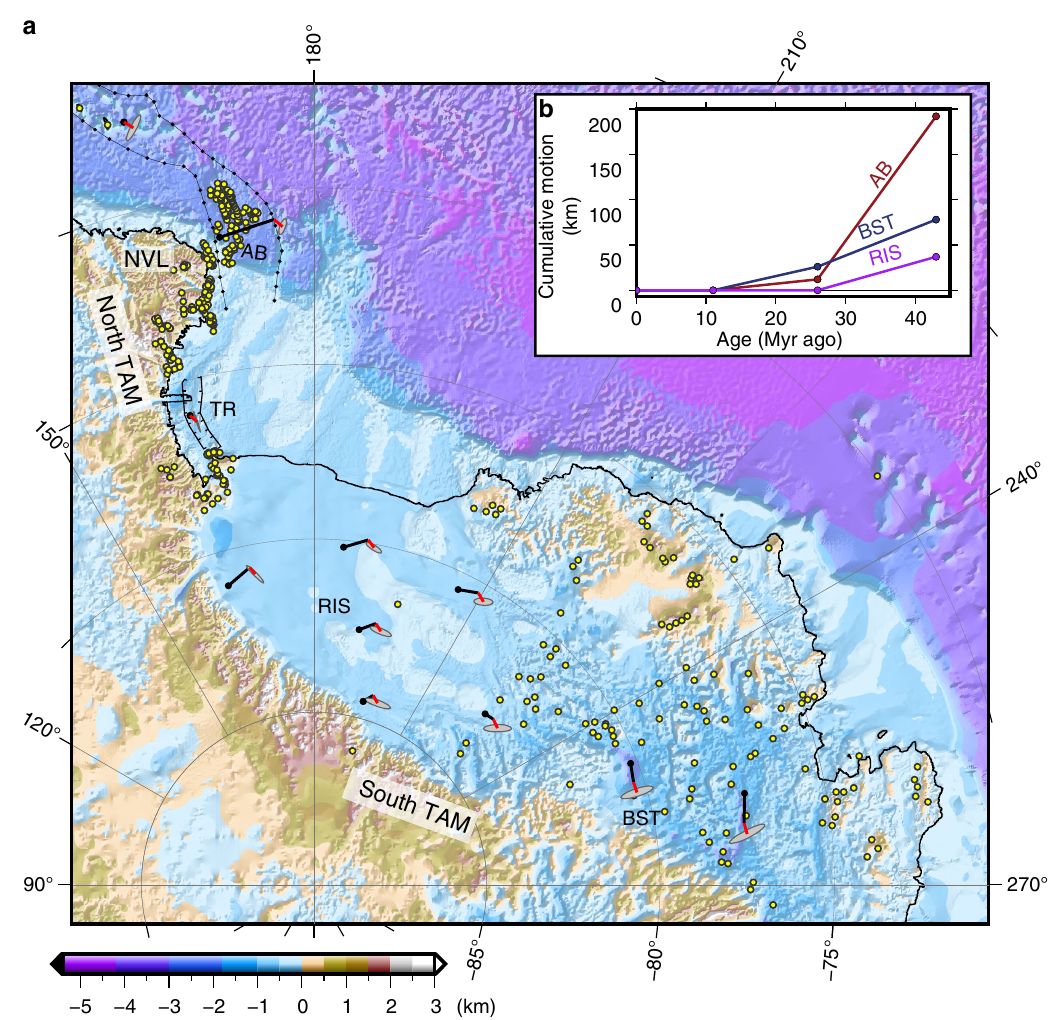
Fig. 5 Predicted late Cenozoic displacements and their 95% con fi dence ellipses in the West Antarctic rift system. a Black lines show the displacements of East Antarctica relative to a fi xed West Antarctica for the Eocene-Oligocene, calculated by extrapolating the stage pole 18o – 12o 18 to cover the entire spreading period recorded by the Adare Basin (anomalies 20o – 8o). Early Neogene displacements are shown by red lines with their 95% con fi dence ellipses. Only Neogene displacements are plotted in the locations of the Balleny Islands and Terror Rift. Yellow circles show mapped volcanoes 9,21,41 . Background map shows bedrock elevation and bathymetry 54 . b Cumulative motion perpendicular to the front of the TAM and the East-West Antarctic plate boundary. The Ross Ice Shelf (RIS) curve was calculated at location 84.5° S, 195.0° E. AB, Adare Basin; TR, Terror Rift; NVL, Northern Victoria